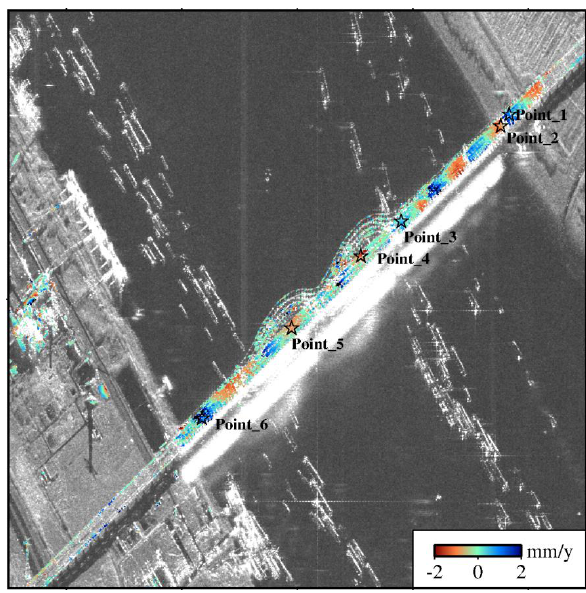
Figure 4. Deformation rates of bridge